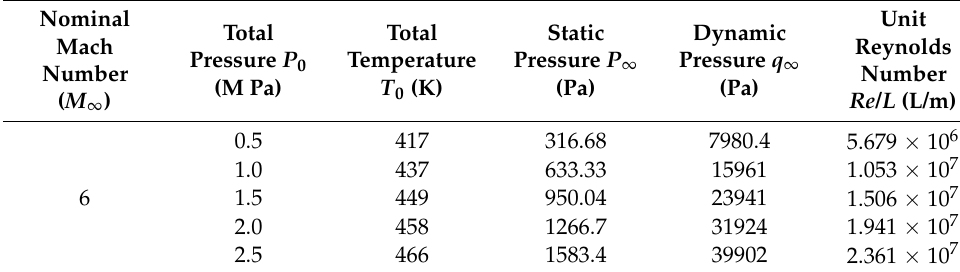
Table 1. The main parameters of the wind